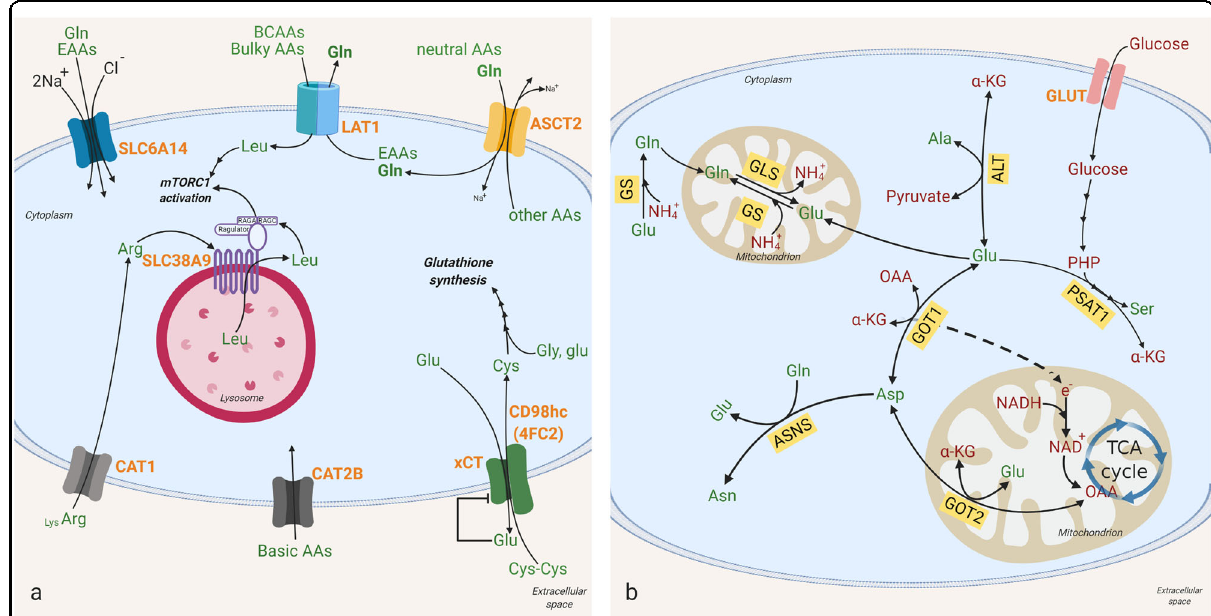
Fig. 4 Amino acid transporters and transaminases. a , b Cells can either import amino acids from the extracellular environment or synthesize them inside the cell. Amino acid transporters are required to transfer them across the plasma membrane (shown in a ), and transaminases are required to generate amino acids from sugar precursors and nitrogen from other amino acids (shown in b ). Amino acid transporters and transaminases contribute to metabolic reprogramming in cancer through manipulation of the amino acid pool inside and outside cancer cells. Their impact on the tumor microenvironment is associated with tumor aggressiveness; some induce tumor cell growth and expansion through activation of signaling pathways (e.g., mTORC1 activation) or inactivation of tumor suppressors, while others result in apoptotic cell death. Amino acids are in green, and other metabolites are in red. Bright red represents transporters. Yellow boxes signify enzymes. The relative sizes of Lys and Arg represent the tendency to be transferred across CAT1 in a cancer setting. SLC6A14 solute carrier family 6 member 14, LAT1 large-neutral amino acid transporter 1, ASCT2 alanine, serine, cysteine-preferring transporter 2, xCT/CD98hc (4FC2) cystine/glutamate heterodimeric antiporter, CAT2B cationic amino acid transporter 2B, CAT1 cationic amino acid transporter 1, GLS glutaminase, GS glutamine synthetase, PSAT1 phosphoserine aminotransferase 1, AST aspartate aminotransferase, also known as glutamic oxaloacetic transaminase (GOT). GOT1 is in the cytosol and GOT2 in mitochondria, ASNS asparagine synthetase, ALT alanine aminotransferase, EAA essential amino acid, Na + , sodium ion, Cl − chloride ion, Gln glutamine, Leu leucine, AA amino acid, Gly glycine, Glu glutamic acid, Cys cysteine, Cys cystine, Lys, lysine, NH 4 + ammonium ion, Asn asparagine, Ala alanine, Asp aspartic acid, Ser serine, PHP 3-phosphohydroxypyruvate, α -KG alpha-ketoglutarate, e − electron, NADPH reduced nicotinamide adenine dinucleotide phosphate, NAD + oxidized NADPH, OAA